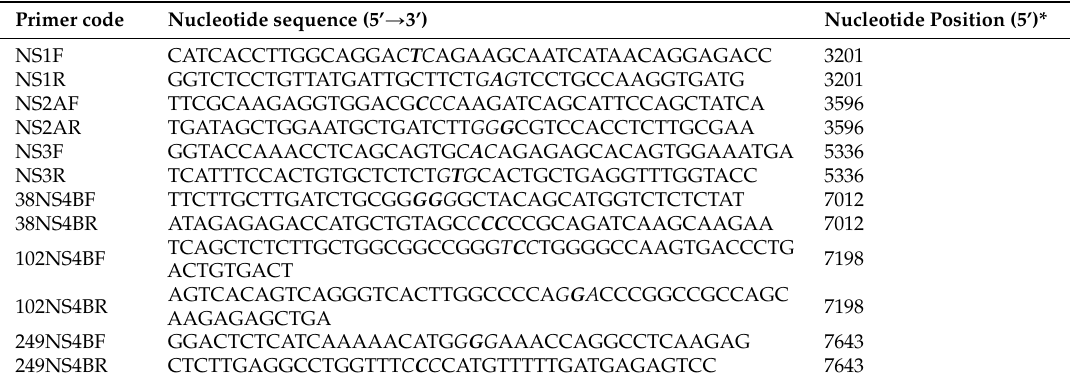
Table 2. List of primers used to insert point mutations into the genome of WNV-578/10. Primer code Nucleotide sequence (5’ Ñ